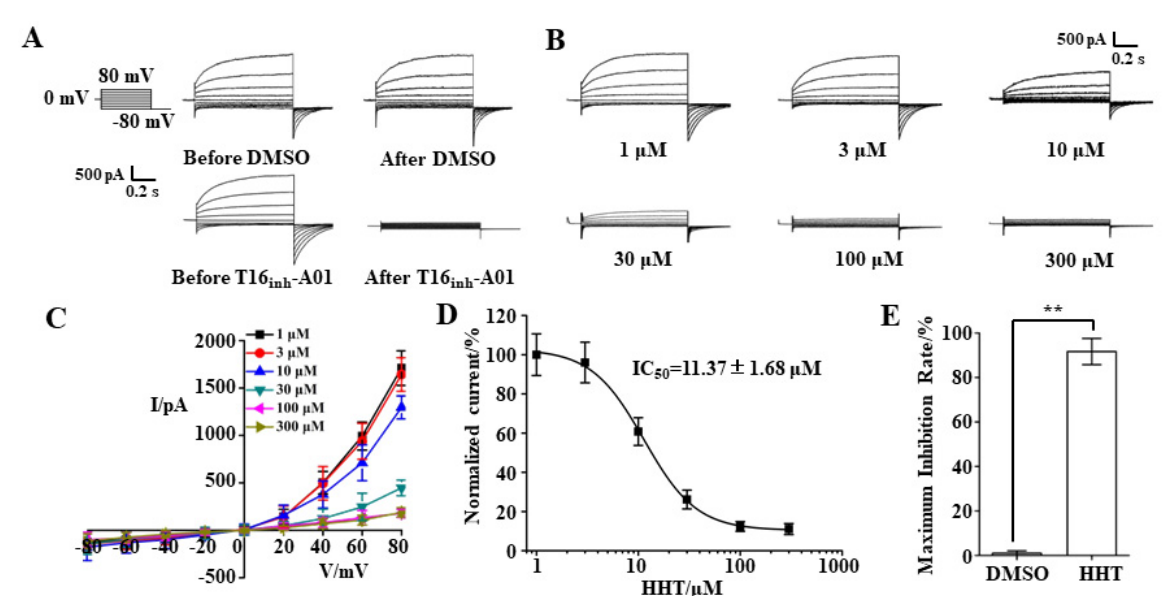
Figure 2. HHT inhibited TMEM16A whole-cell current in LA795 cells. ( A ) Typical TMEM16A whole-cell currents of DMSO and 16A inh -A01 perfusion in LA795 cells ( n = 5). ( B ) Typical TMEM16A whole-cell currents inhibited by different concentrations of HHT ( n = 5). ( C ) I–V curve of the TMEM16A currents inhibited with different concentrations of HHT ( n = 5). ( D ) Dose-response curve for HHT inhibition of TMEM16A currents in LA795 cells ( n = 5). ( E ) Statistical results of the maximum inhibition rate of HHT on LA795 whole-cell currents ( n = 5, ** p < 0.01).